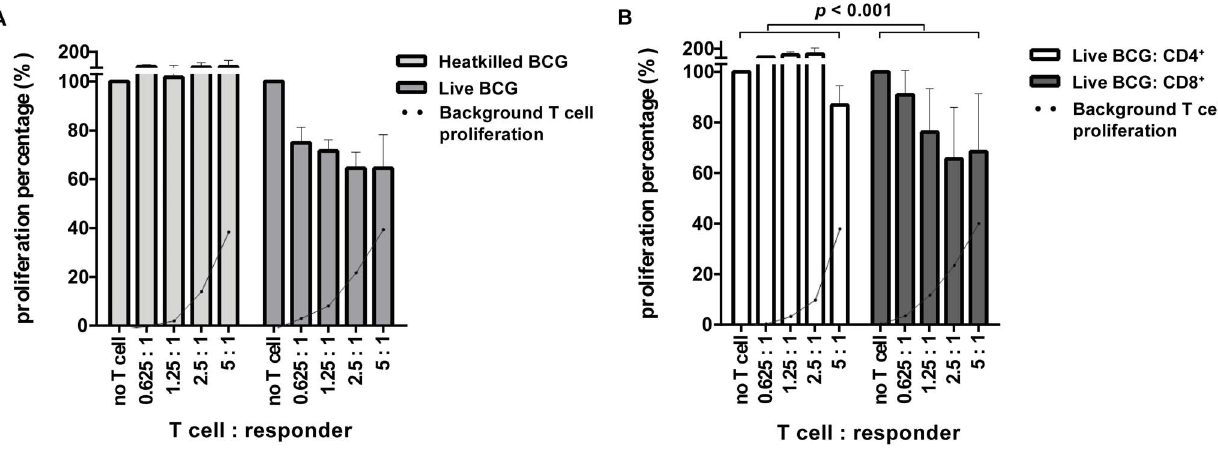
Figure 4. Suppressive activity resides predominantly in live BCG-activated CD8 + T cells. Heatkilled BCG-activated and live BCG-activated T cell lines were expanded, and live BCG T-cell lines were enriched for CD4 or CD8 expression using magnetic beads. Suppressive capacity was tested in a co-culture assay by titrating these T cell lines onto a Th1 reporter clone that was stimulated with its cognate peptide [30,31]. Proliferation was measured by (3H)TdR incorporation after three days. Proliferation was divided by Th1 reporter clone proliferation in the absence of Treg cells to obtain relative proliferation as described previously [30–32]. Dotted lines represent background proliferation of T cells, in the absence of reporter clone peptide, relative to Th1 clone proliferation. A. Suppressive activity was confined to live BCG-activated T cells, and could not be demonstrated for heat-killed BCG-specific T cells. Data are depicted as mean + SE of five different heat-killed BCG-activated T cell lines, and six live BCG-activated T cell lines. B. Suppressive activity resides predominantly in CD8 + T cells, and not in CD4 + T cells (mean + SE of CD4 + and CD8 + T cell lines of three donors, tested in at least two independent assays; Wilcoxon signed-ranks test, p , 0.001).